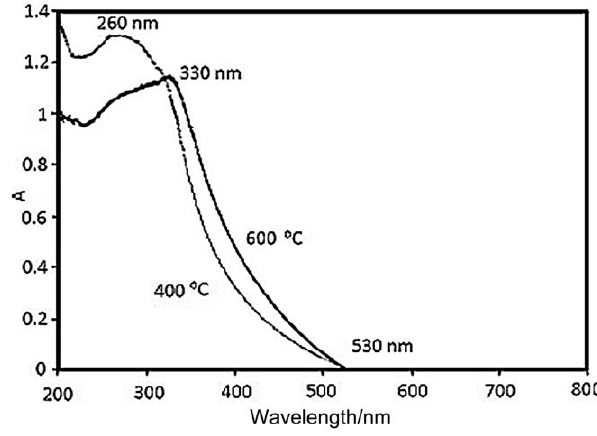
Figure 4. Extinction spectra of sample 1 calcinated at 400 and 600 6 C.